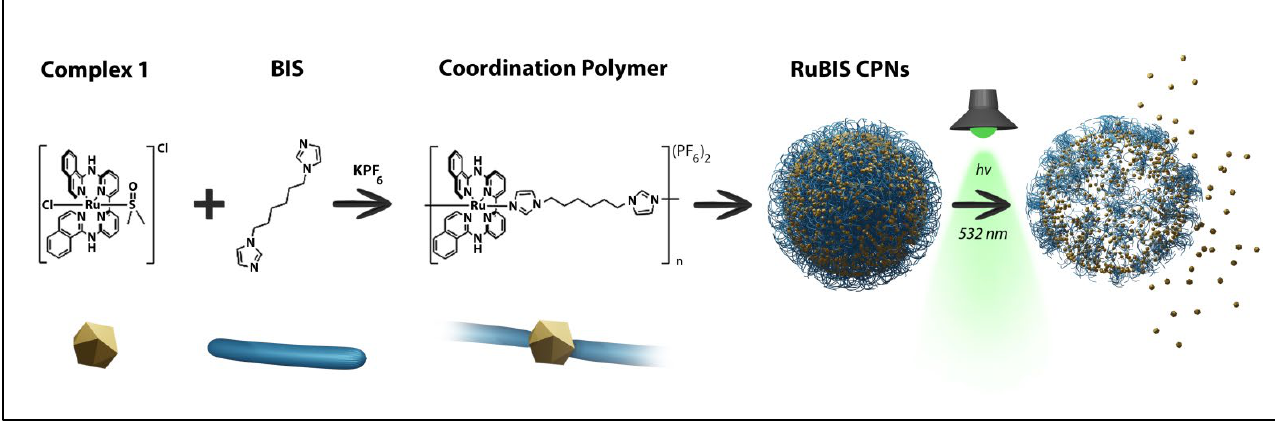
Figure 1. Scheme of synthesis and photoactivation process of Ru-based coordination polymer nanoparticles ( RuBIS CPNs).